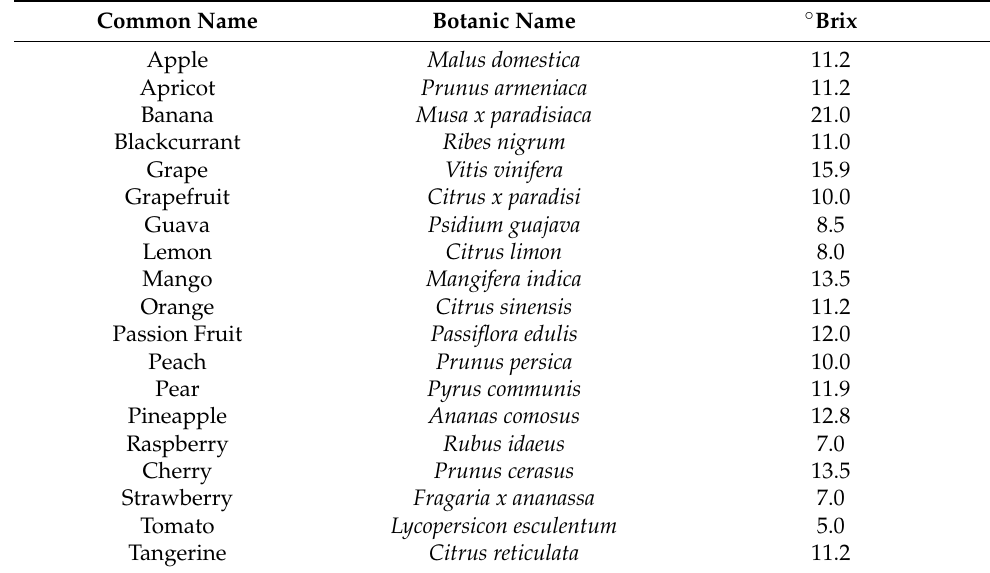
Table 1. Minimum ◦ Brix expected from the different fruit